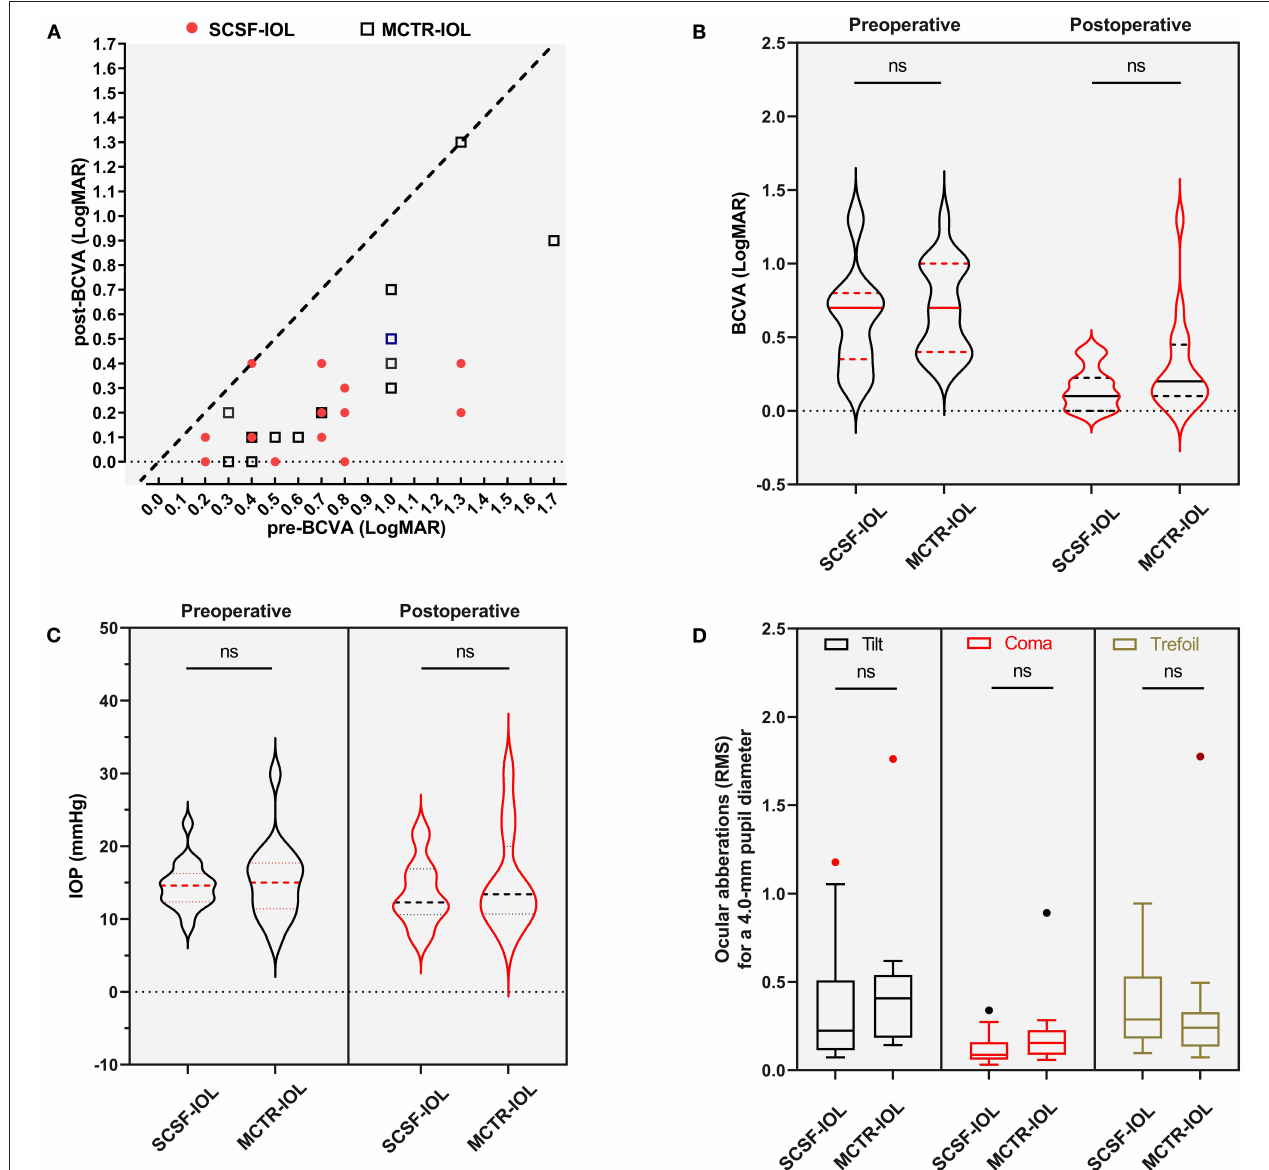
FIGURE 3 | Comparison of surgical outcomes of SCSF-IOL and MCTR-IOL in eyes with MSP. (A) Scatterplot of preoperative and postoperative BCVA on final follow-up in the SCSF-IOL (red dots) and MCTR-IOL (black square) groups. (B) Nested violin graph of preoperative and postoperative BCVA on final follow-up in the SCSF-IOL and MCTR-IOL groups. The medians are shown in solid lines, and the interquartiles are presented as dashed lines. (C) Nested violin graph of preoperative and postoperative IOP on final follow-up in the SCSF-IOL and MCTR-IOL groups. The medians are shown in solid lines, and the interquartiles are presented as dashed lines. (D) Comparison of postoperative ocular aberration (tilt, coma, and trefoil) between SCSF-IOL and MCTR-IOL groups. BCVA, best-corrected visual acuity; IOP, intraocular pressure; SCSF-IOL, supra-capsular and scleral-fixated intraocular lens implantation; LogMAR, logarithm of the minimal angle of resolution; MCTR-IOL, transscleral-fixated modified capsular tension ring and in-the-bag intraocular lens implantation. RMS, root mean square.